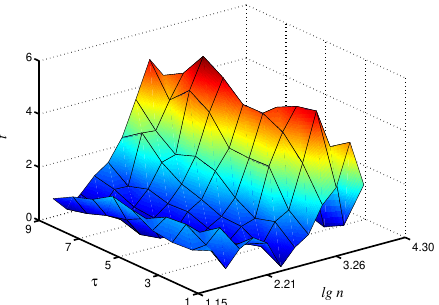
Figure 6. Statistical analysis of differences in local α values by Student’s t -test. Improvement by 34% compared to τ = 1 is